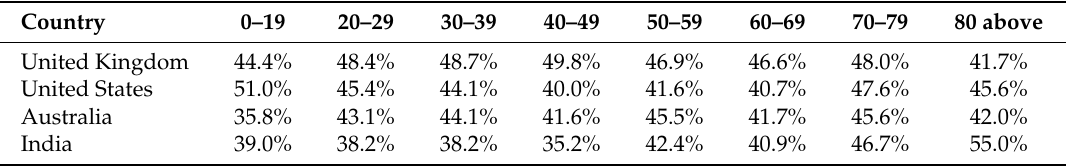
Table 3. The C > T ratios in different age groups in the United Kingdom, United States, Australia, India, and the